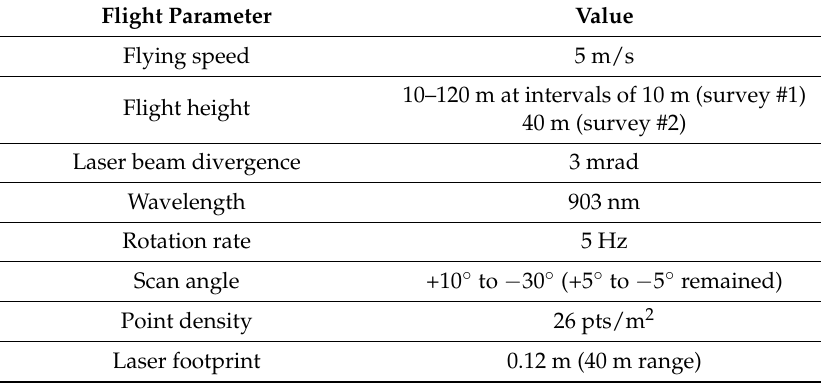
Figure 4. A ground-based photograph indicating the Li-Air fitted with Velodyne’s HDL-32E lidar sensor. Table 2. Flight parameters of Velodyne HDL-32E lidar dataset.